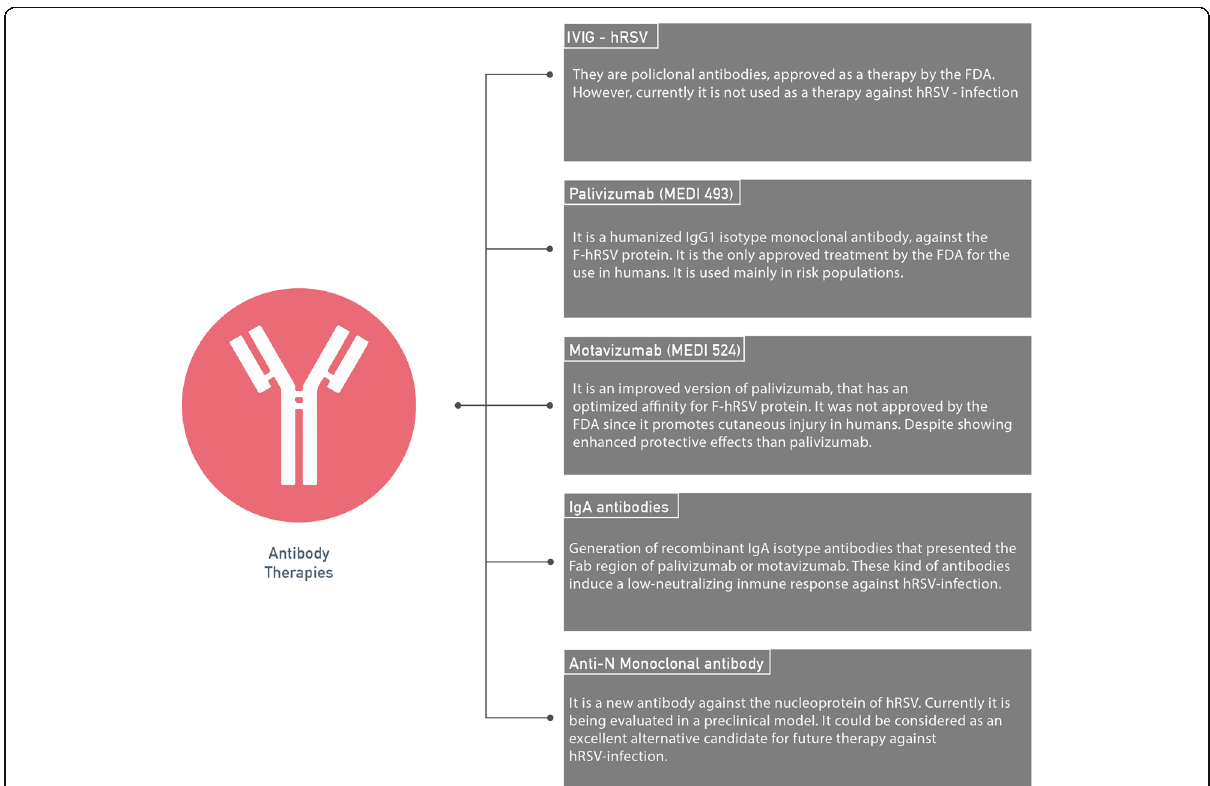
Fig. 2 Development of antibody therapies against hRSV infection. The five main types of antibody therapies against the hRSV-infection are described. Also, these therapies are shown in order of development, highlighting that the only approved therapy to be used in humans to date is palivizumab. However, an interesting new possibility is also described at the end of the figure, associated with a therapy based on the use of the monoclonal anti-N-hRSV